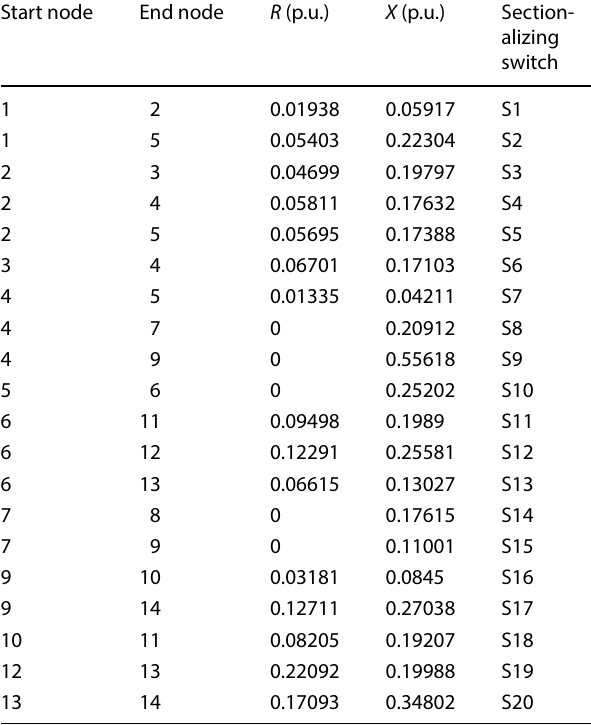
Table 16 The 14-node test system line data [39] Start